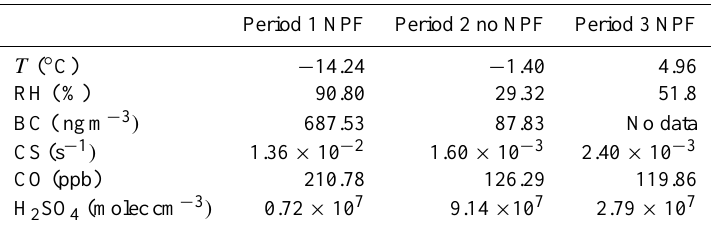
Table 3. Summary of the mean values of several atmospheric parameters for each sub-period. The occurrence of NPF during the sub-periods is indicated in the table. February 2012, Puy de